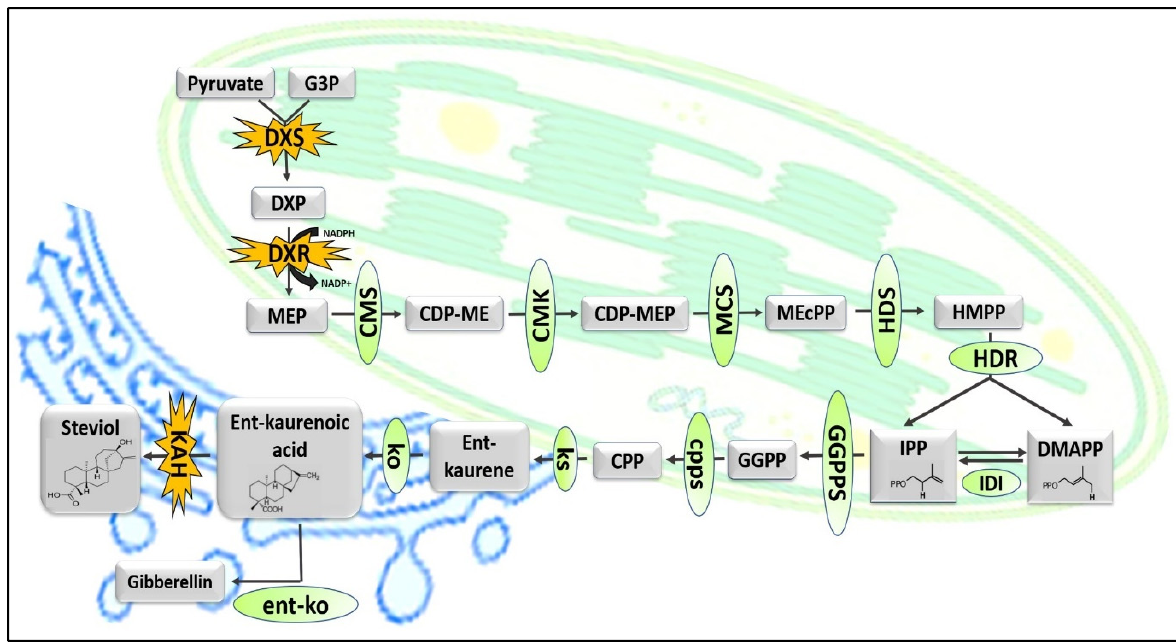
Figure 1. Schematic depiction of the biosynthesis of steviol glycosides by MEP pathway outlining the important enzymes involved in the pathway. G3P = Glyceraldehyde 3-phosphate; DXS = 1-de- oxy-D-Xylulose 5-Phosphate; DXR = 1-deoxy-D-xylulose 5-phosphate reductoisomerase; MEP = 2- C-Methyl-D-erythritol 4-phosphate; CMS = CDP-ME synthase; CDP-ME = methylerythritol cytidyl diphosphate; CMK = CDP-ME kinase; CDP-MEP = 4-diphosphocytidyl-2-C-methyl-D-erythritol-2- phosphate; MCS = 2-C-methyl-D-erythritol 2,4-cyclodiphosphate synthase; MEcPP = 2-C-methyl-D- erythritol-2;4-cyclodiphosphate; HDS = 4-hydroxy-3-methylbut-2-enyl diphosphate synthase; HMPP = 4-hydroxy-3-methyl-butenyl 1-diphosphate; HDR = 4-hydroxy-3-methylbut-2-enyl diphos- phate reductase; IPP = Isopentyl diphosphate; DMAPP = dimethylallyl diphosphate; GGPP = geranylgeranyl diphosphate; GGPPS = GGPP synthase; CPPS = copalyl diphosphate synthase; CPP = ent-copalyl diphosphate; KS = ent-kaurene synthase; KO = kaurene 19-oxidase; ent-KO = ent kaurene 19-oxidase.